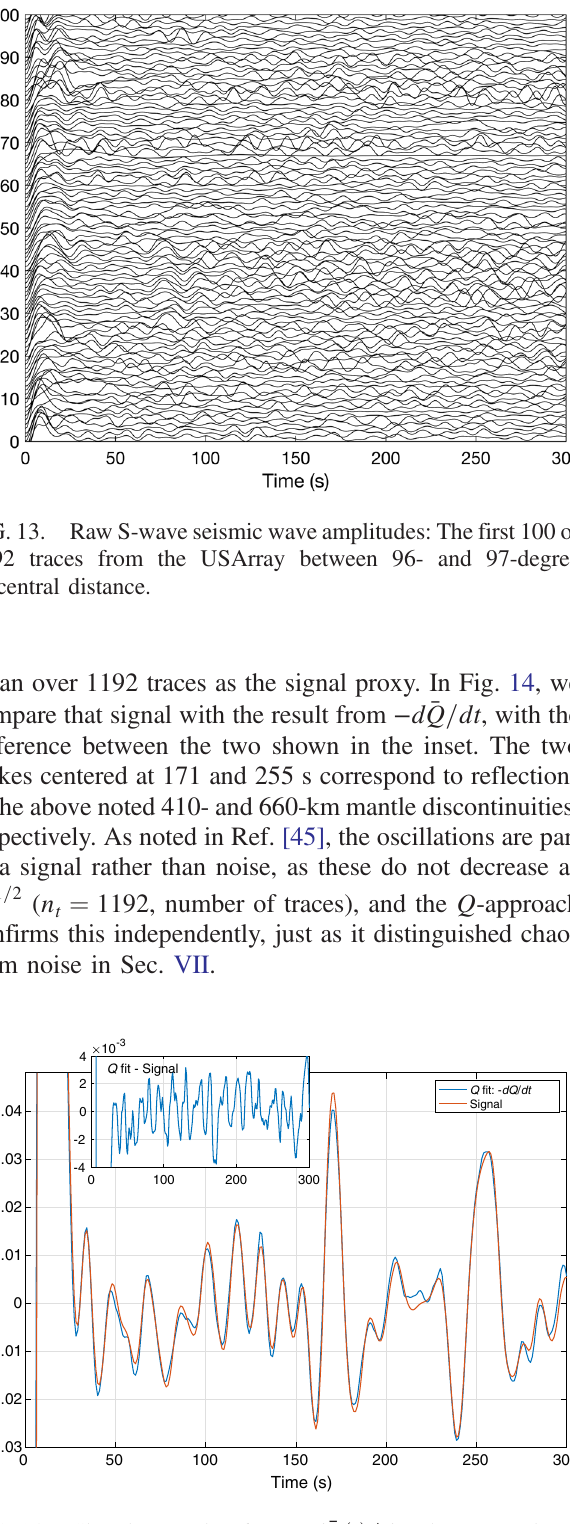
¯ Q FIG. 14. Signal extraction from − d ð t Þ =dt : The conventional method (red curve) is to average the noisy individual 1192 traces illustrated in Fig. 13. The resulting S-wave peaks at 171 and 255 s are linked to mantle discontinuities at 440 and 660 km. The assumption-free, ordinal signal extraction (blue curve) from − d ¯ Q=dt matches remarkably well, particularly the